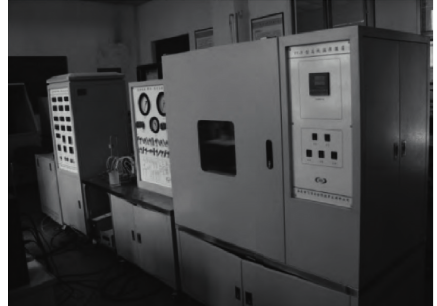
Figure 6: Adsorption-desorption